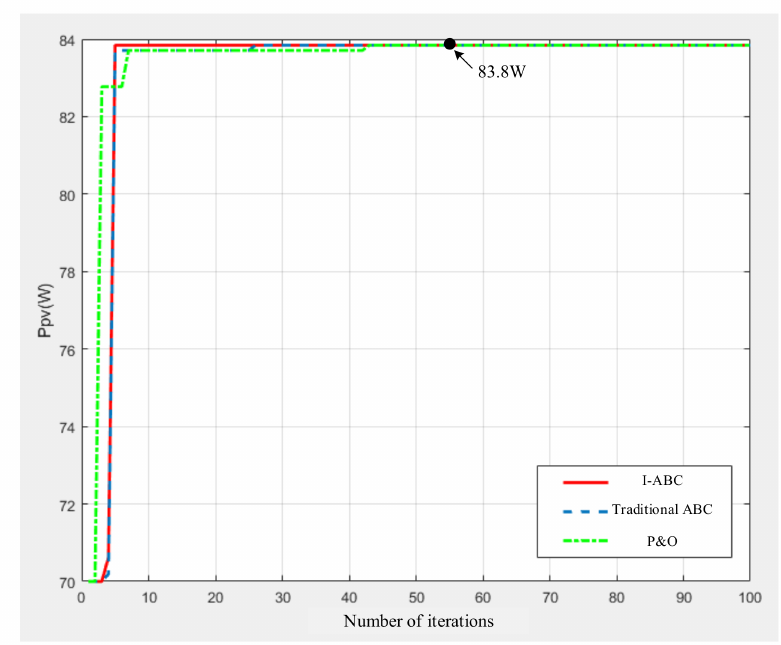
Figure 13. Comparison of simulation results for the MPPT in Case 4.